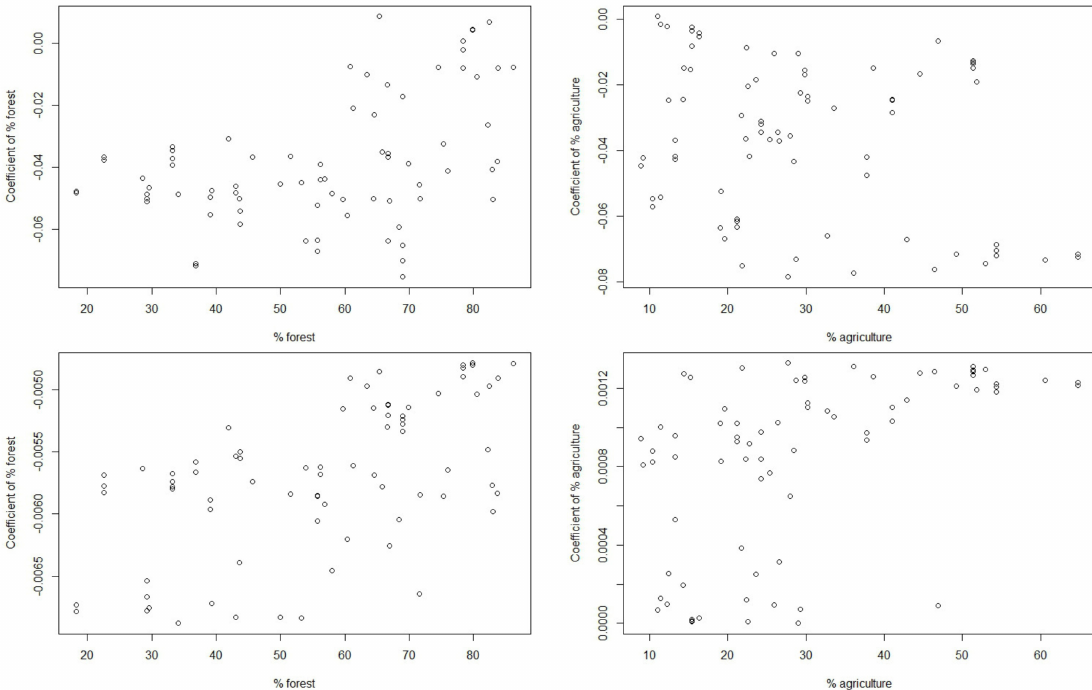
Figure 4. Scatterplots of the percentage of land use and the coe ffi cients of land use in the estimated GWR models for BOD (upper left), DO (upper right), NH 3 -N (bottom left), and PO 4 -P (bottom